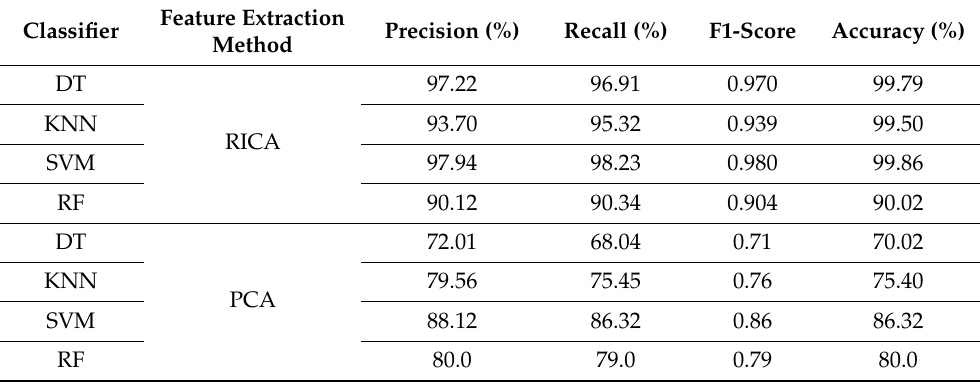
Table 5. Overall results achieved using Decision Trees, SVM and KNN with the RICA and PCA feature extraction